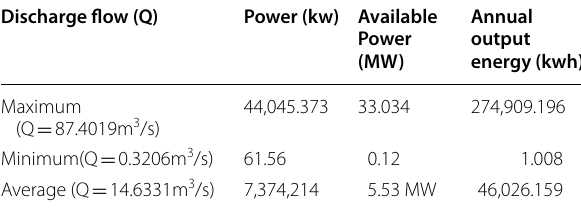
Table 4 Power, available power and annual output energy of different discharge flow (Fraenkel et al. 1991)